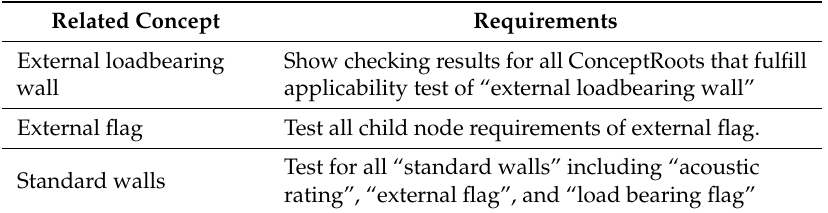
Table 2. Examples of requirements.